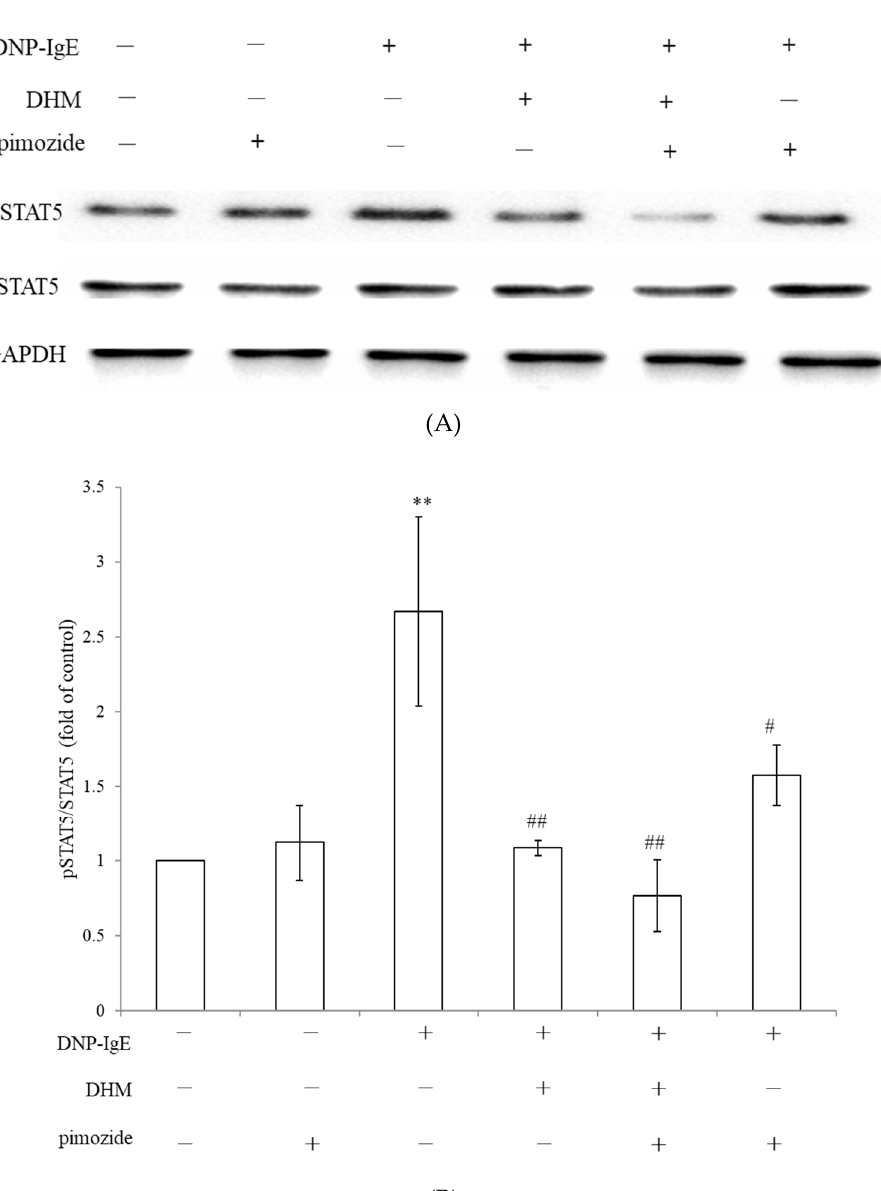
Figure 5. DHM inhibits the IgE-inducing STAT5 pathways in KU812 cells. Representative western blots of p-STAT5 ( A ). Protein expression in KU812 cells, cells treated with DNP-IgE, 10 µ M pimozide, 100 µ M DHM, or both compounds combined. Pimozide in combination with DHM suppressed the expression of p-STAT5 compared with either compound alone. The relative ratio of phosphorylated protein to total protein levels were presented as the mean ± SD ( B ). Fold of control, ** p < 0.01, # Fold of DNP IgE, # p < 0.05, ## p <